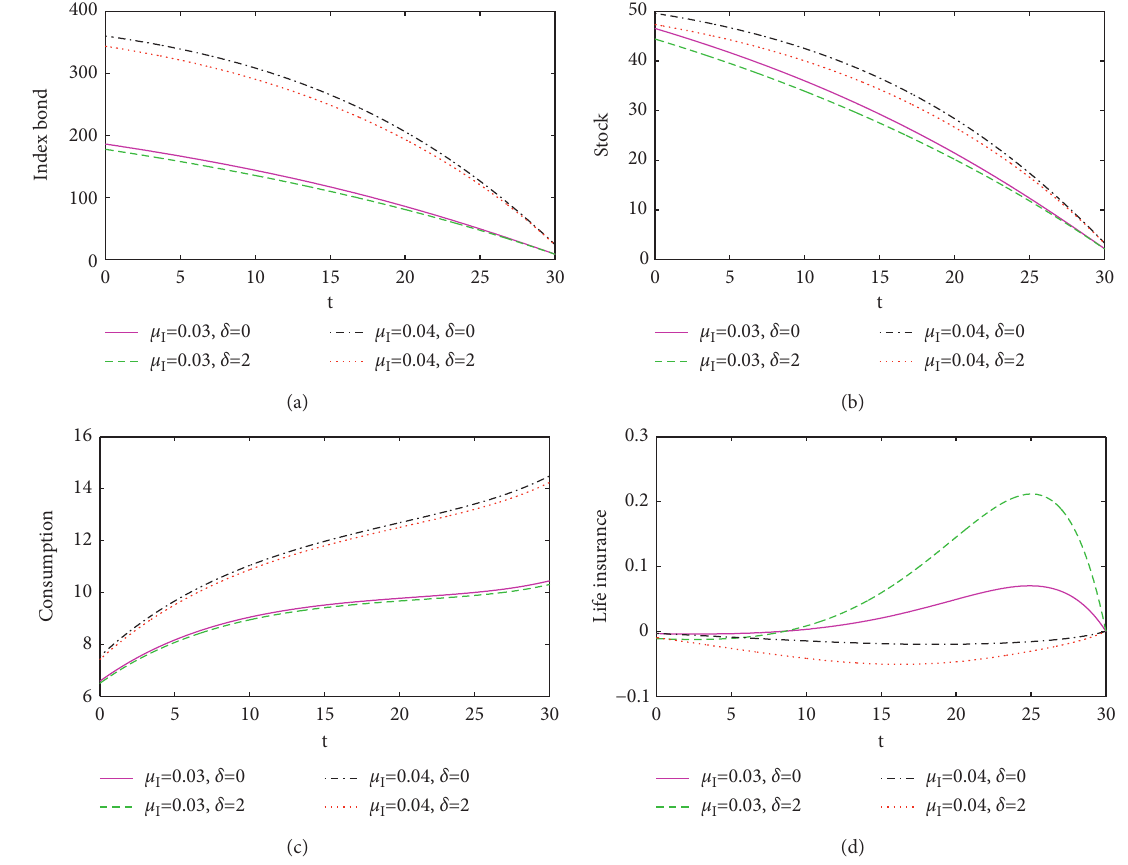
Figure 3: The effects of the expected inflation rate and mortality force change on the optimal